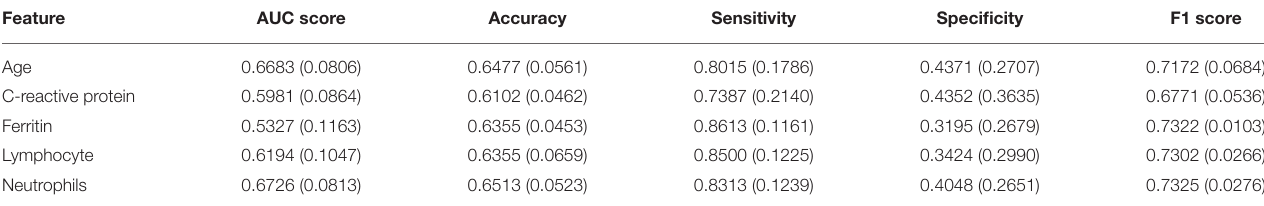
TABLE 5 | Results of single feature